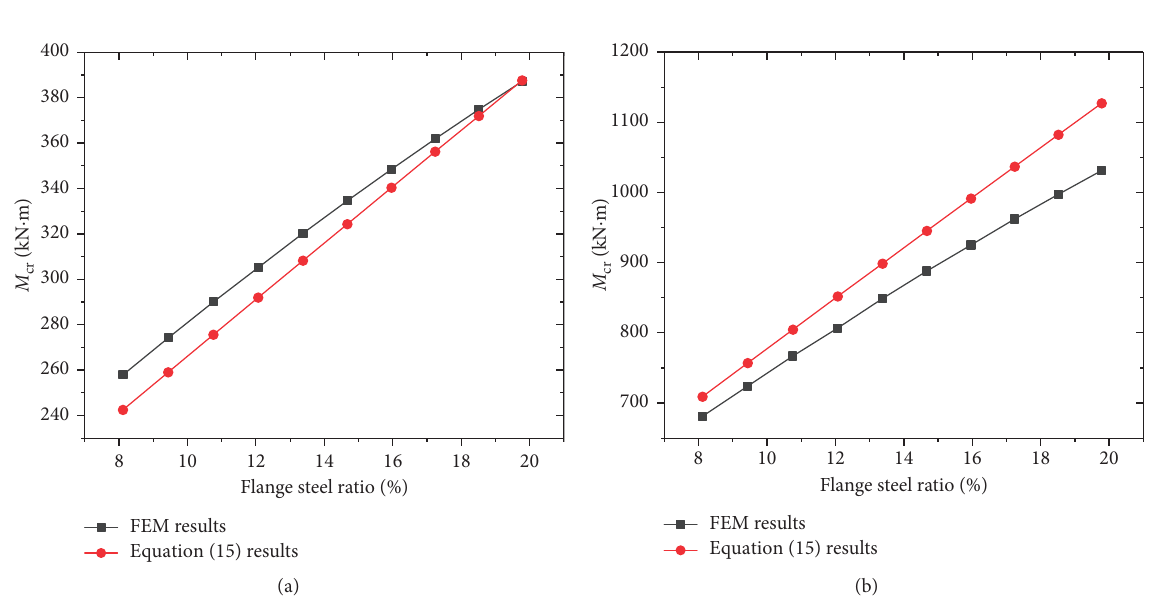
Figure 14: Relationship between critical moments and flange steel ratio. (a) 􏽥 R � 0. (b) 􏽥 R � 􏽥 R